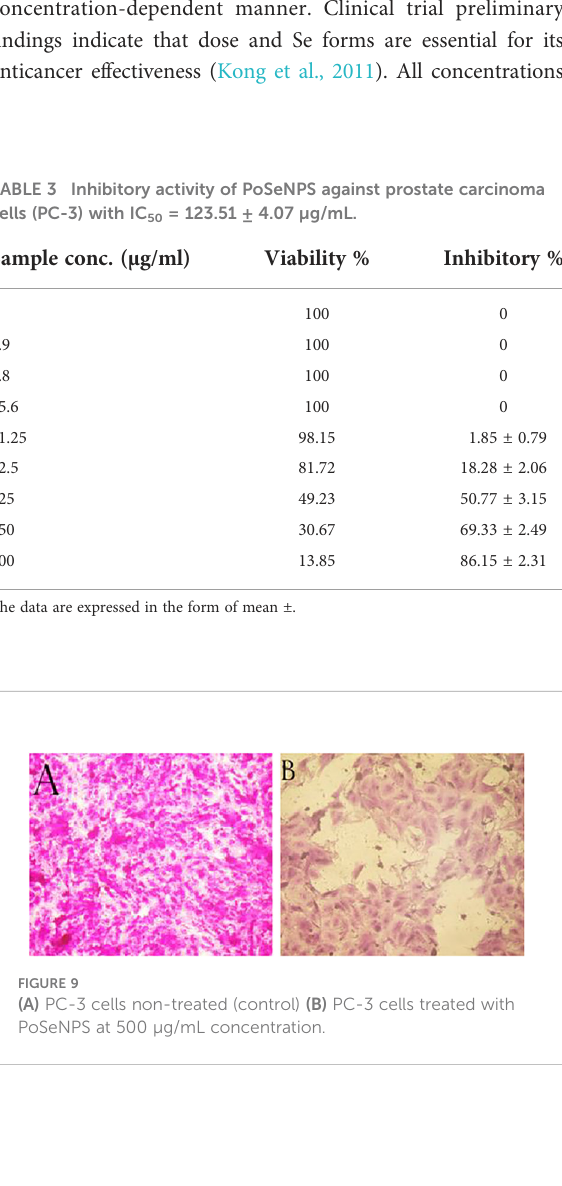
The data are expressed in the form of mean